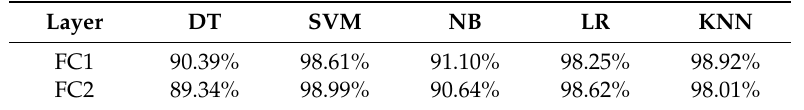
Table 14. Computed